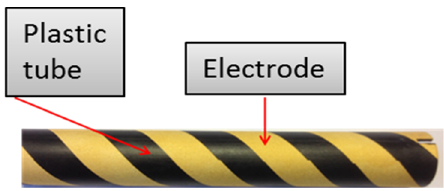
Figure 26. Industrial sensor’s fabrication.